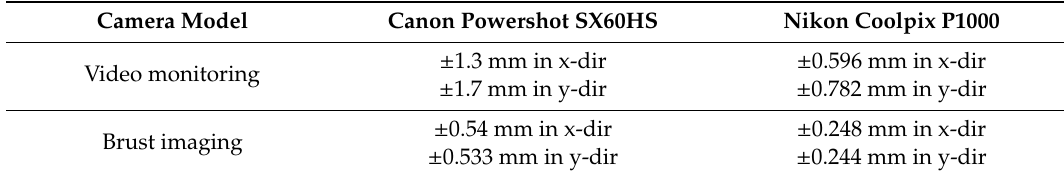
Table 2. Summary of analyzed camera sensors precision for monitoring target 100 m apart.